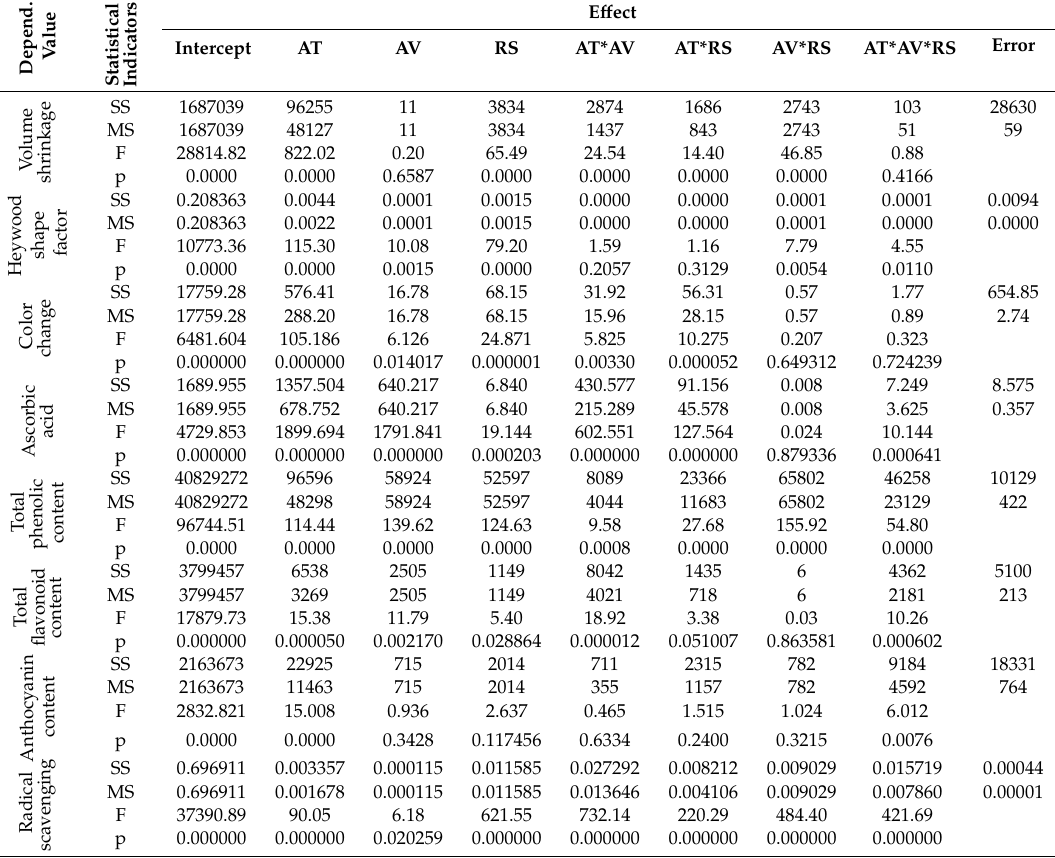
Table 1. Statistical analysis of convective drying factor e ff ect on all determined quality indicators.